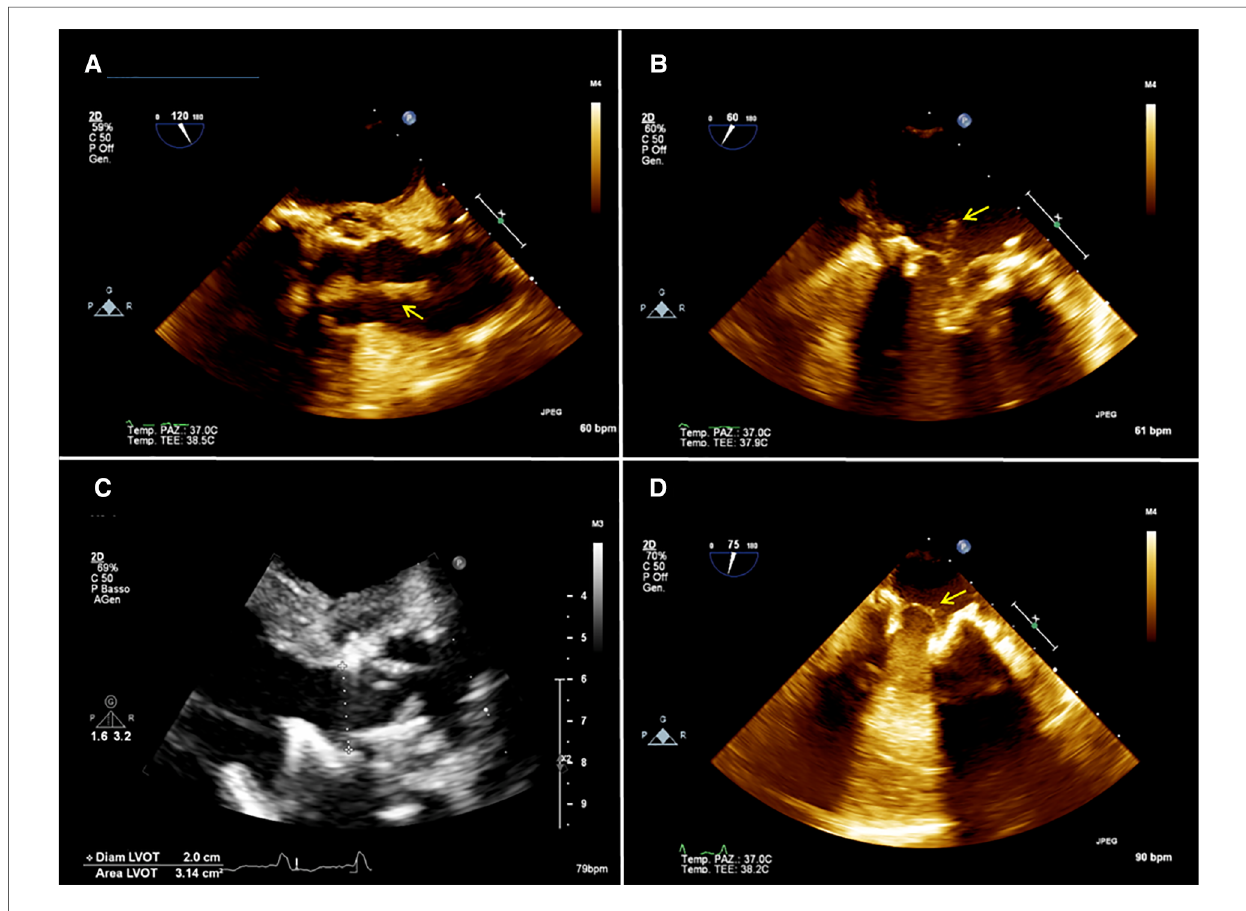
FIGURE 2 ( A ) 2D preoperative transesophageal echocardiography (TEE) showing the presence of a mass (arrow) attached to the aortic prosthesis and fl oating in the aortic root. ( B ) 2D preoperative TEE showing a mass (arrow) attached to the mitral prosthesis on the atrial side. ( C ) postoperative 2D TEE showing no residual mass on the aortic prosthesis. ( D ) postoperative 2D TEE showing a residual minimal stump (arrow) on the mitral